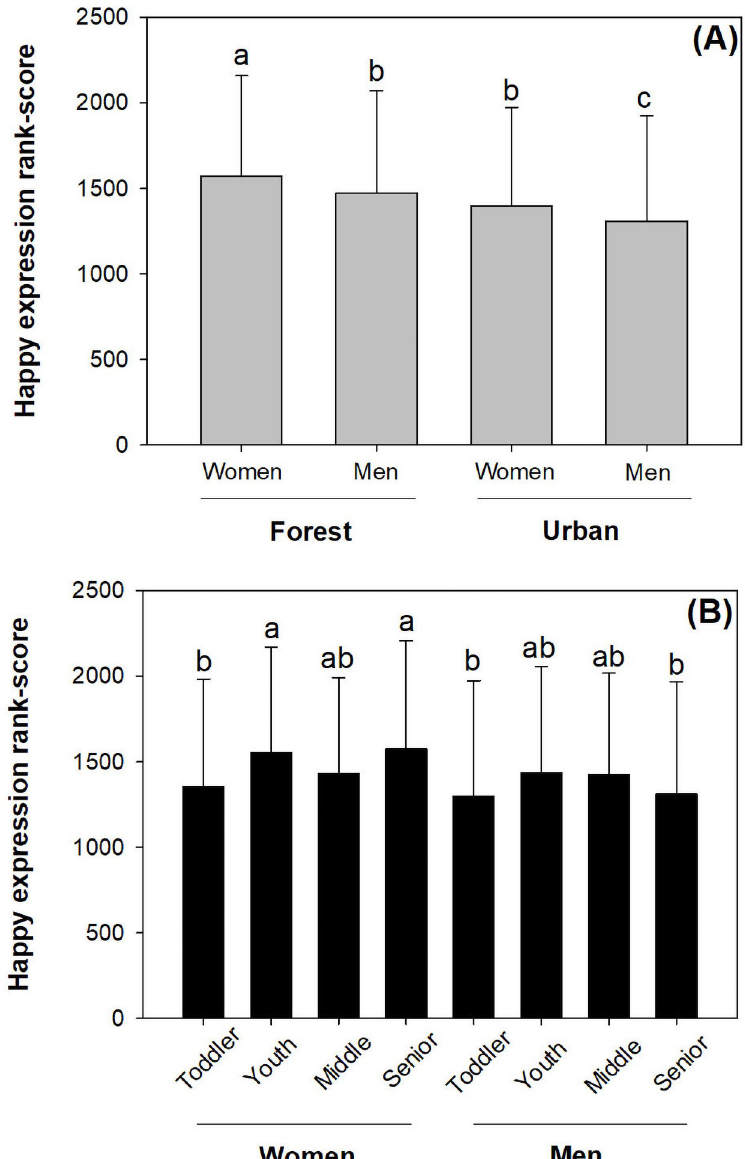
Fig 3. Happy expression scores for men and women at different ages in forest and urban locations. Scores have been transformed by ranking. Bars stand for standard errors. Different letters indicate significant difference according to Duncan test at 0.05